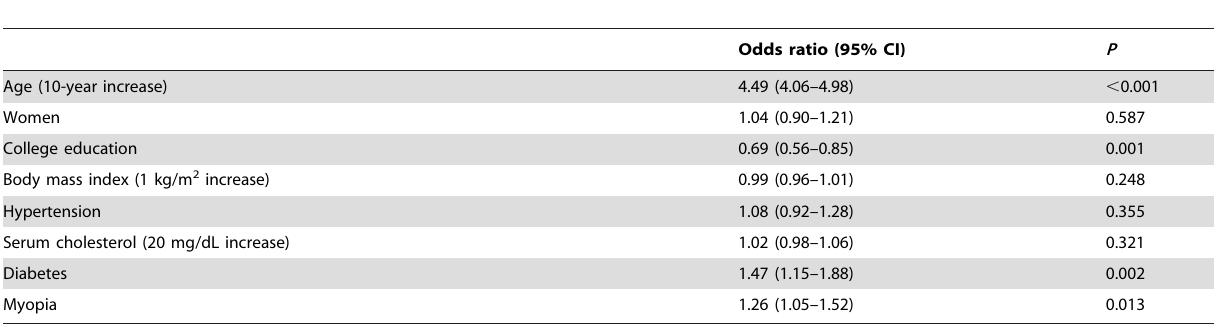
Table 5. Logistic regression analyses for lens opacity in the Korean adult